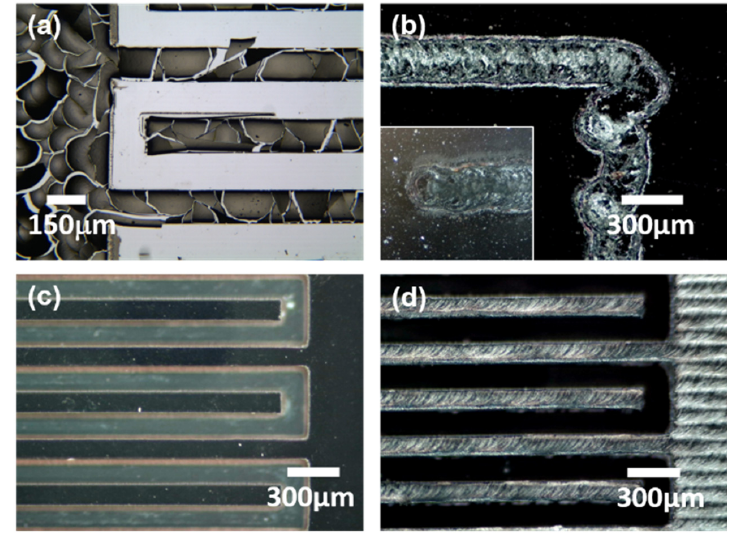
Figure 3. Top-view optical microscopy images of ( a ) fragmented furan pattern due to the high- temperature carbonization of the imprinted pattern, ( b ) laser-pyrolyzed pattern near a turning point of direct laser writing (inset: start point of laser scanning), ( c ) imprinted furan pattern, and ( d ) laser-pyrolyzed pattern on imprinted furan.